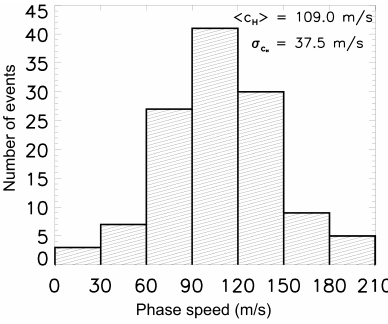
Figure 4. Histogram for the observed horizontal phase speed.